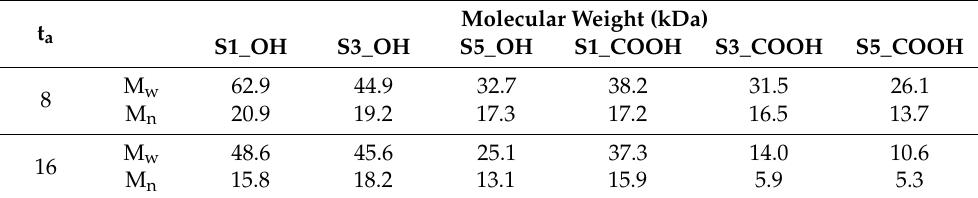
Table 4. GPC number-averaged (M n ) and weight-averaged (M w ) molecular weight of the PLA phase for samples at different aging